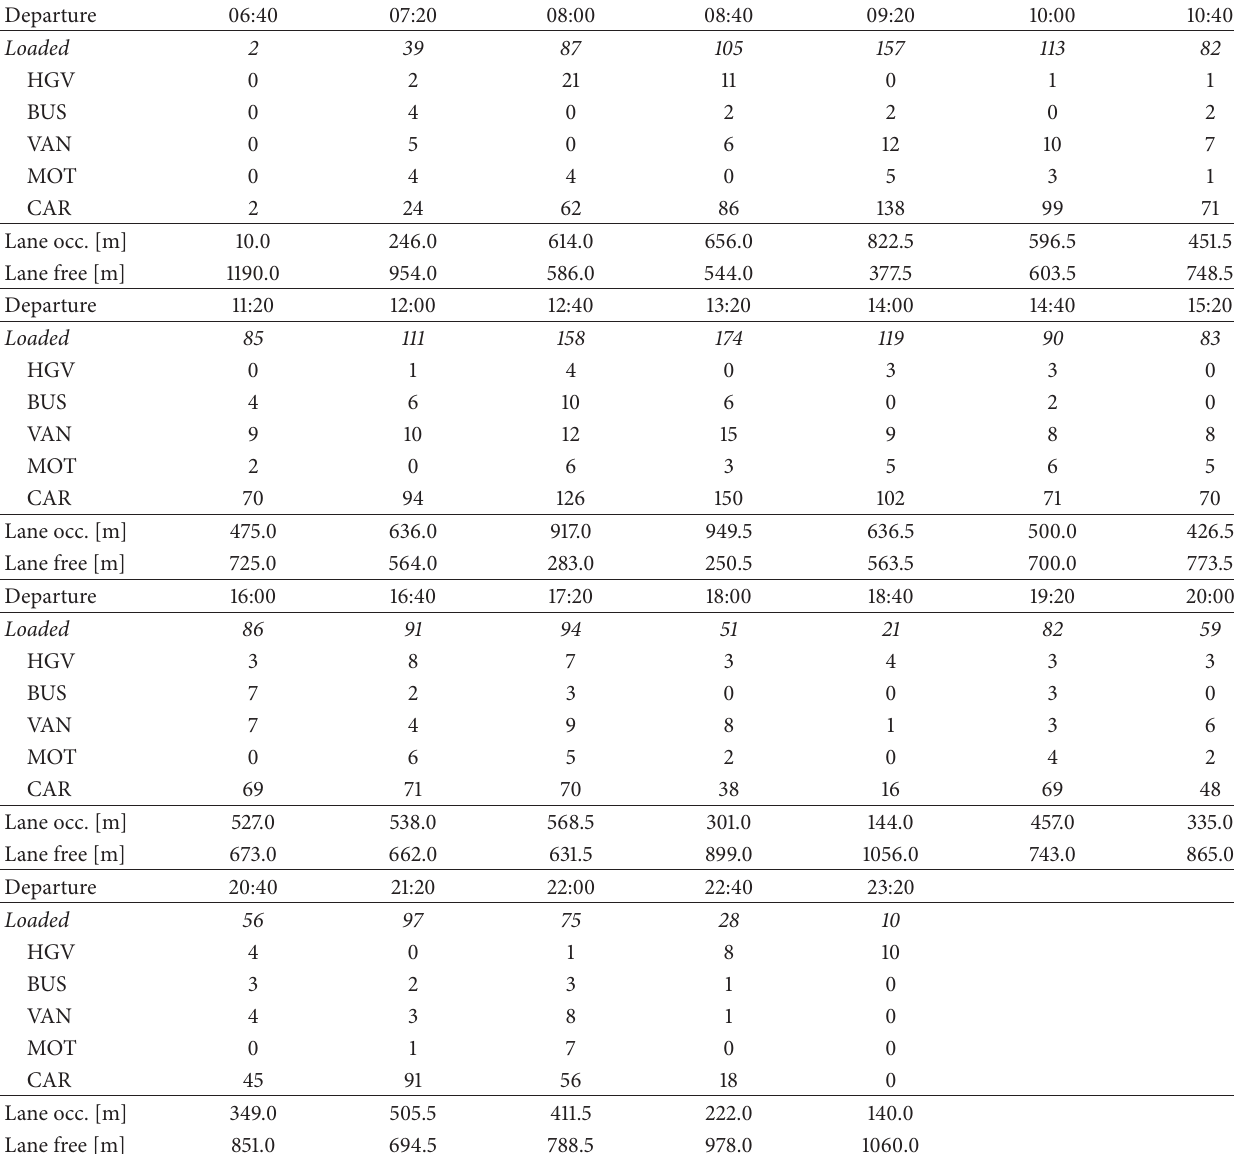
Table 4: Vehicles embarking on any run of the ferry, first